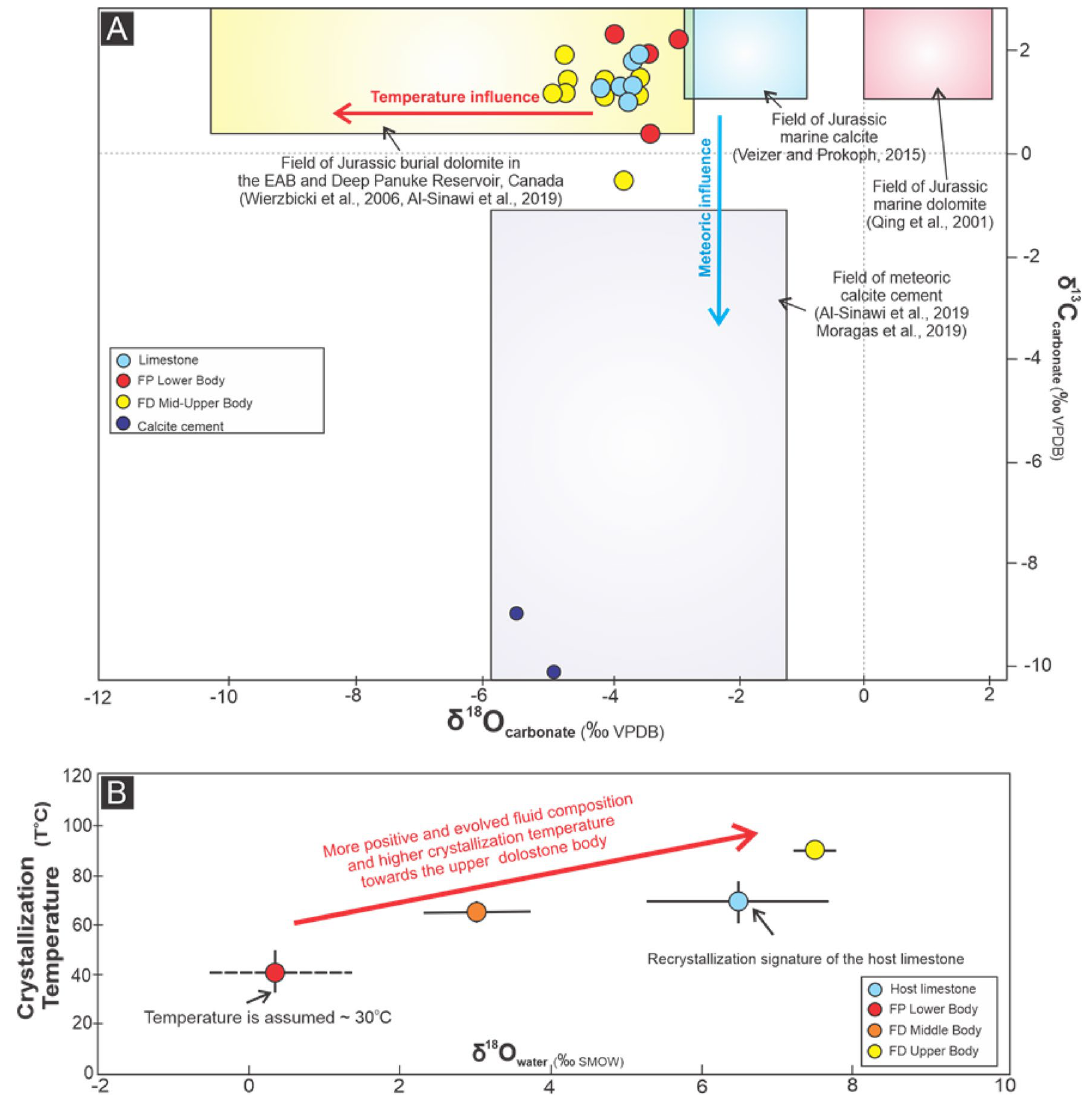
Figure 5. ( A , B ) Cross plots between δ 18 O and δ 13 C, and δ 18 O water and ∆ 47 -derived temperature. Overall, the isotopic values of FP and FD dolomites are comparable and lighter than limestone, respectively 39,42 . A clear trend of more evolved fluid and hotter temperature towards the upper